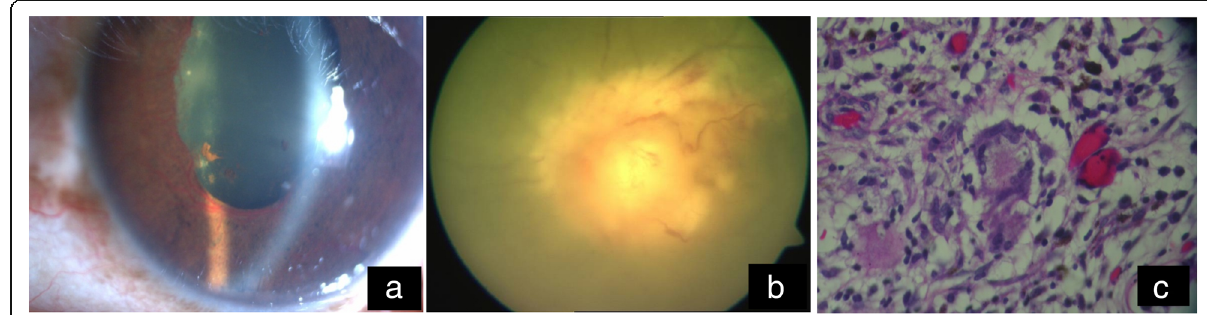
Fig. 4 a , b Progression to panophthalmitis despite improving CD4 counts. c Histopathology of eviscerated tissue showing typical caseation necrosis with epithelioid cells and Langhans giant